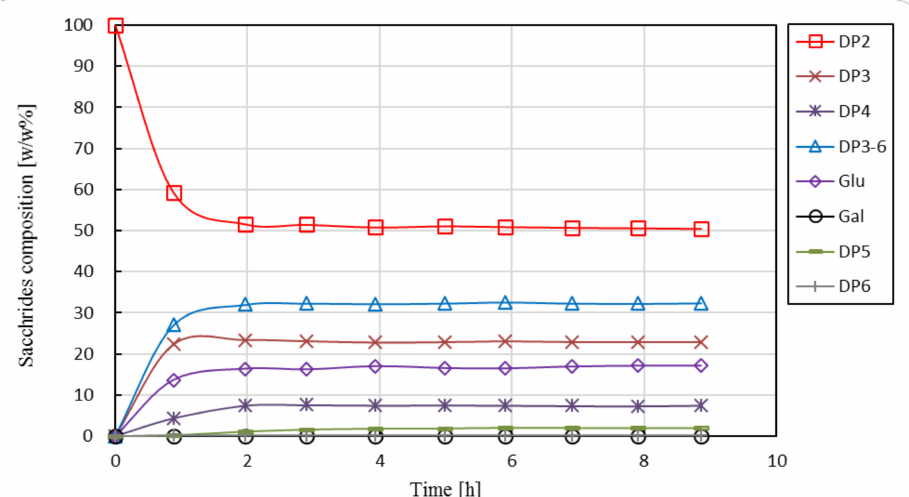
Figure 5. Saccharide composition in permeate of the enzyme membrane reactor as function of operational time during Run No2. Operational conditions: 30 w / w % feed lactose concentration, 30 w / w % initial lactose concentration, 19.1 U · g − 1 enzyme load, pH 6.0, 50 ◦ C, 2.2 h residence time, 0.18 m 3 · h − 1 cross-flow rate, 0.5 bar retentate-side pressure, ca. 0.40–0.45 bar permeate-side pressure, 10 kDa UF